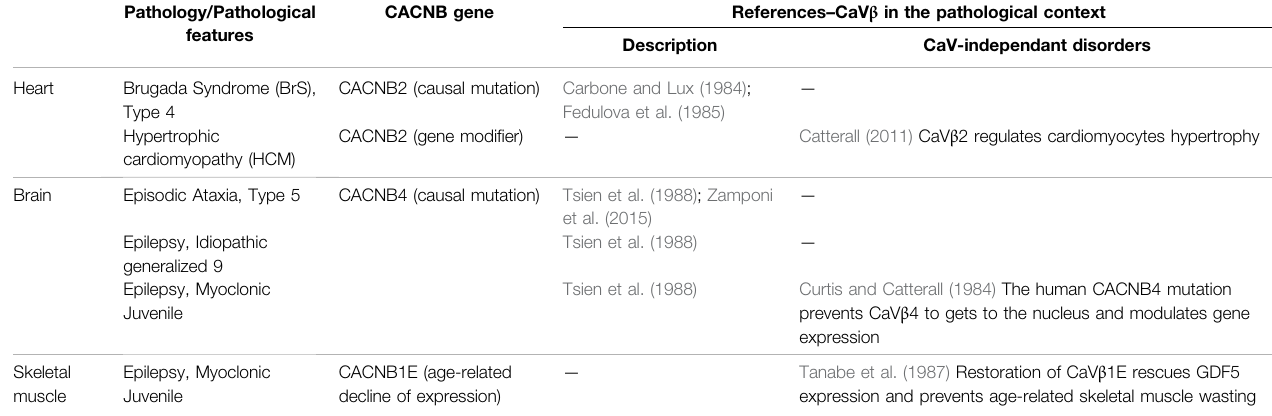
TABLE 1 | CaV β s associated